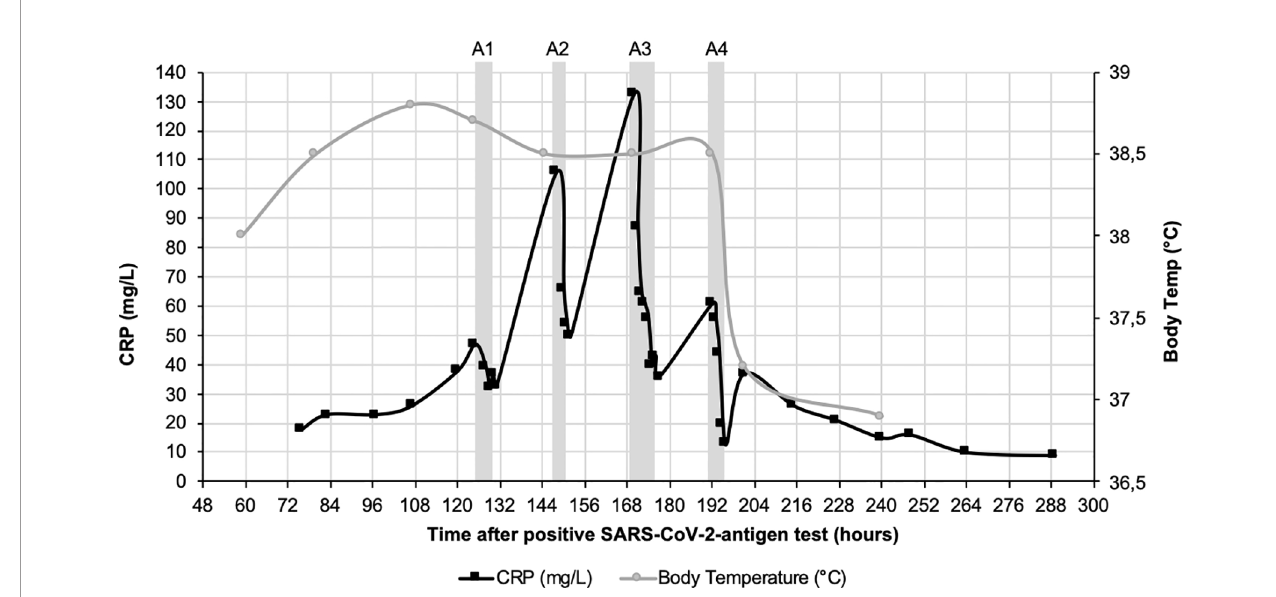
FIGURE 1 | CRP course (black) and course of body temperature (grey) over 12 days after positive SARS-CoV-2-antigen test. CRP concentration was measured in plasma. Fever decreased 8 days after positive SARS-CoV-2 test during the last CRP apheresis. Grey boxes indicate the four apheresis treatments